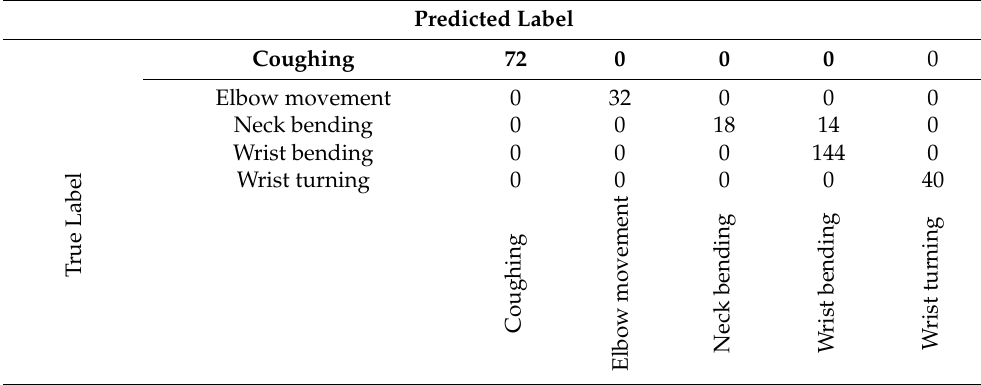
Table 6. Confusion matrix obtained with K-mer-based SVM (number of cuts = 80 and subsequence length =